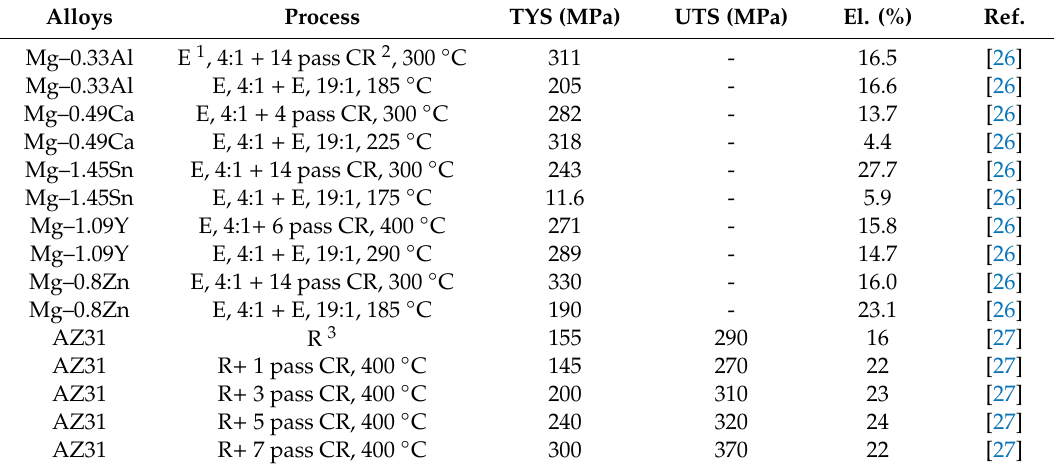
Table 1. Mechanical performance of caliber-rolled (CRed) Mg alloys compared with the corresponding as-extruded samples [26–29]. TYS: tensile yield strength, UTS: ultimate tensile strength, El: tensile